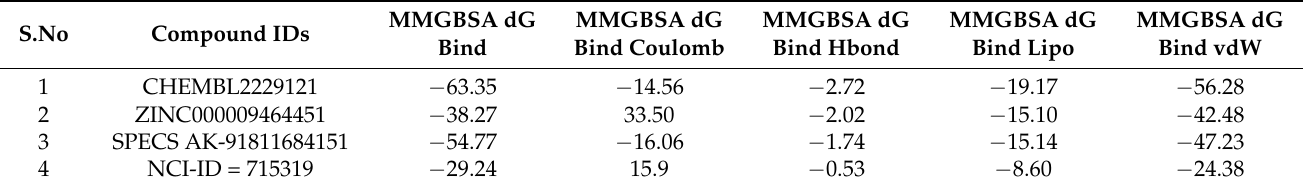
Table 6. MM-GBSA binding energies (kcal/mol) with ligand-receptor conformational changes accounted for in energy terms.